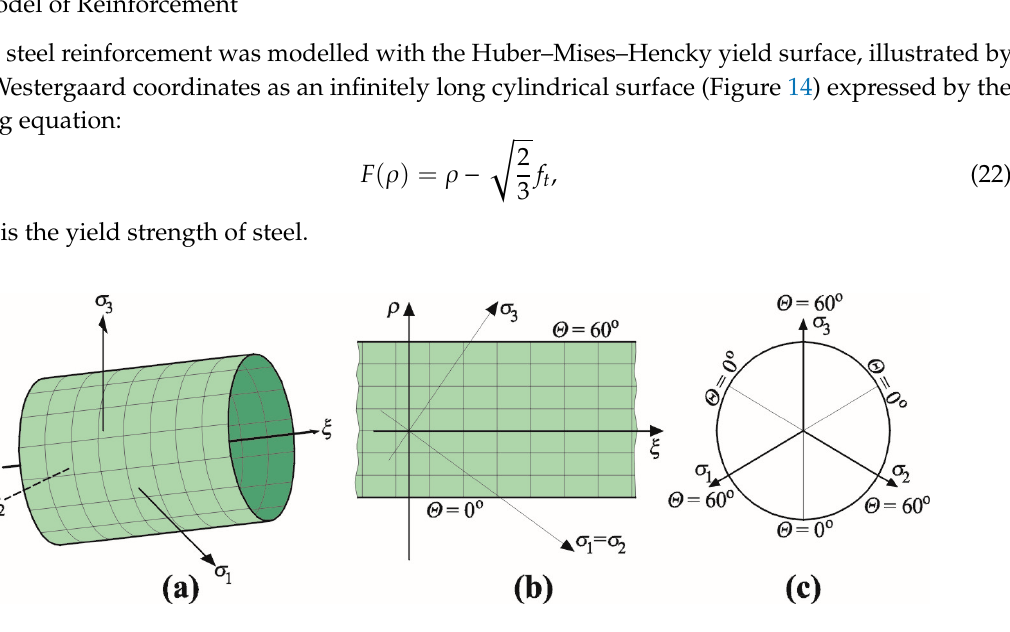
Figure 14. The Huber–Mises–Hencky yield surface: ( a ) the space of principal stresses, ( b ) axiatoric section, ( c ) deviatoric section.